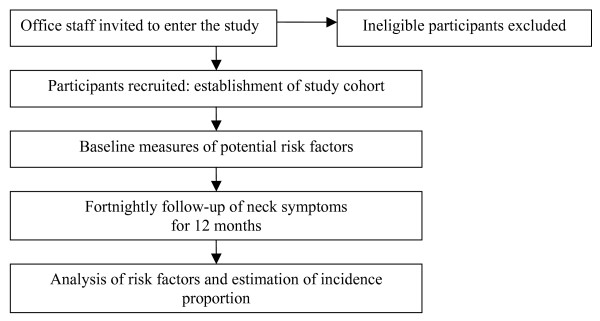
Study flow chart.